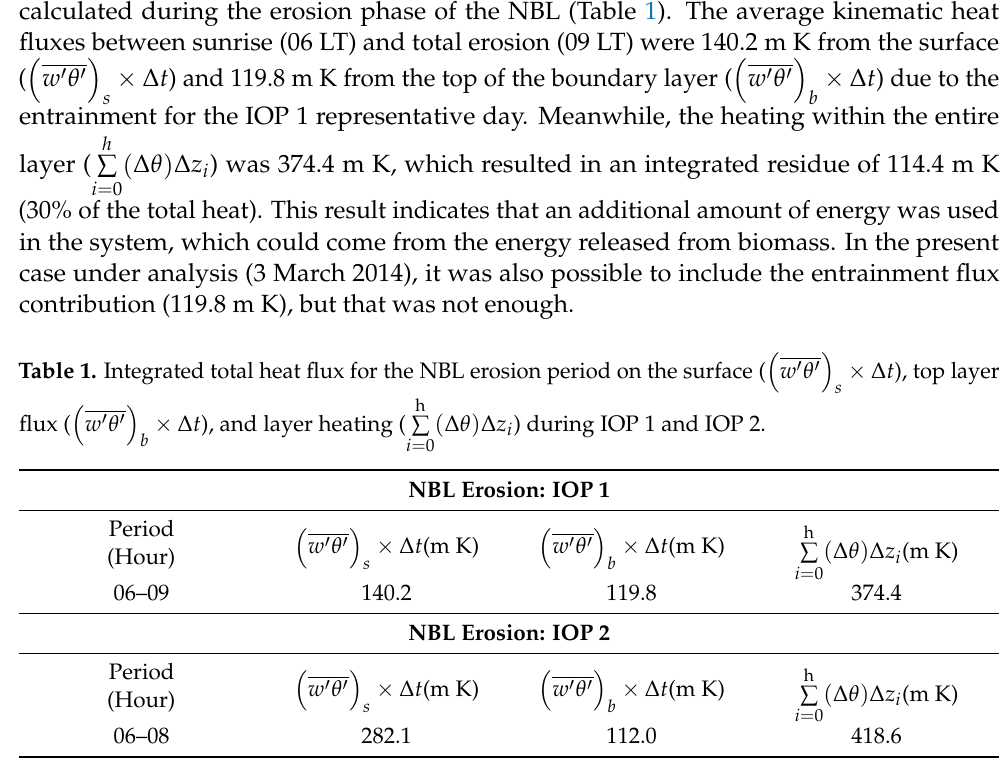
h ∑ ( ∆ θ ) ∆ z i ) during IOP 1 and IOP i = 0